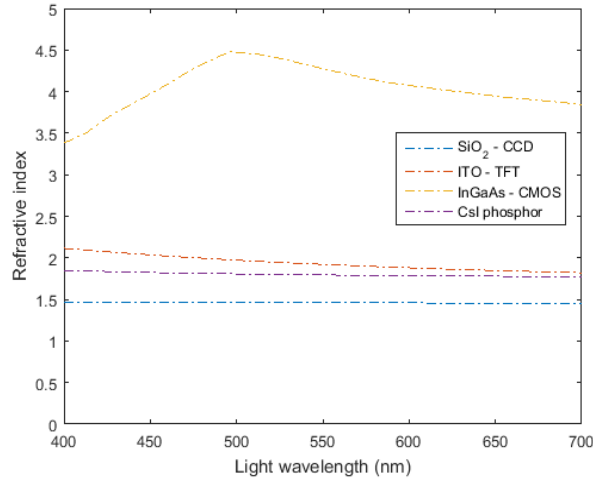
Figure 3. The refractive index as a function of light wavelength (400–700 nm). Figure depicts the refractive index of CsI phosphor and the corresponding refractive indices of three sensing materials: